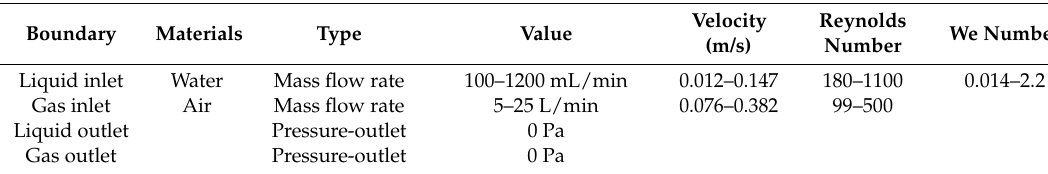
Table 1. Boundary Conditions.